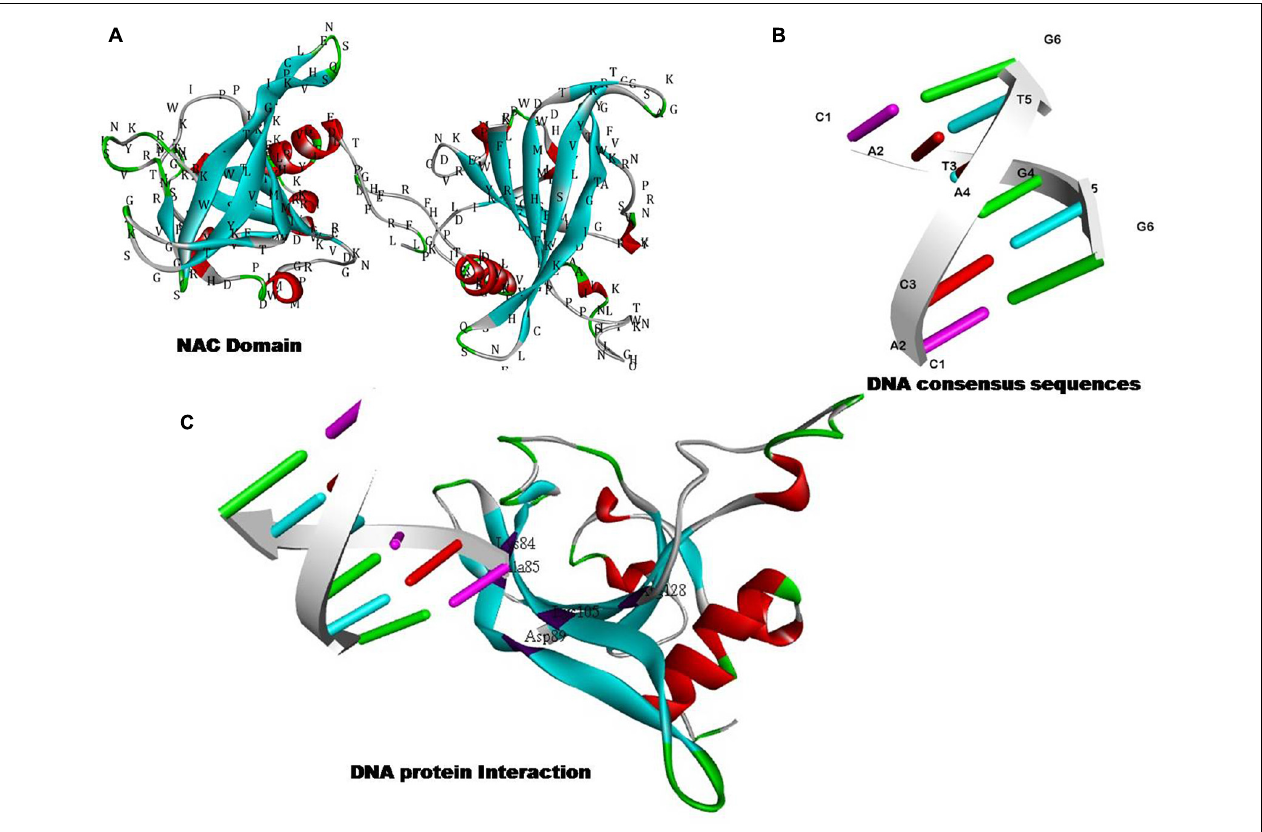
FIGURE 3 | Hypothetical models showing the DNA binding and/or nucleic acid binding transcription factor activity of NAC proteins. (A) The structure of NAC domain. (B) Structure of NAC binding DNA consensus sequences. (C) DNA–protein interaction of NAC proteins with relevant DNA sequences to fine tune the gene regulatory